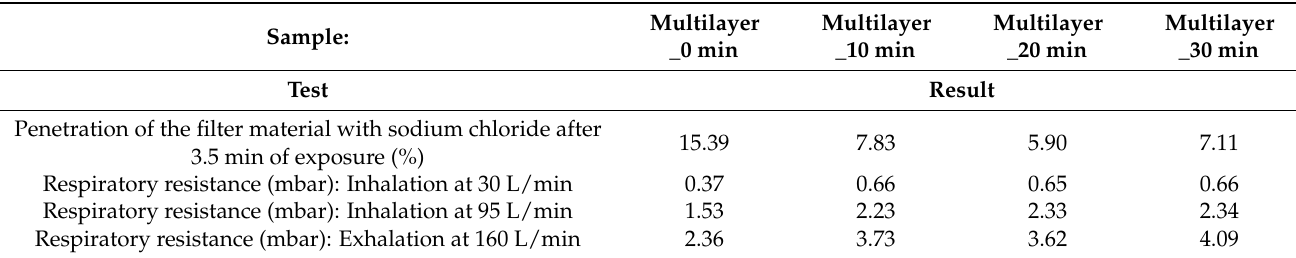
Table 6. Filtration and respiratory evaluation of the four different multilayer systems